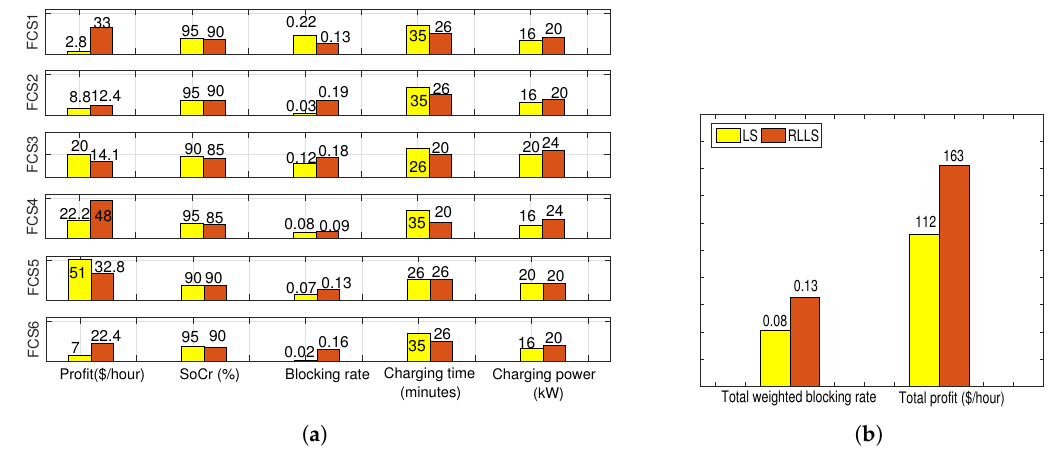
Figure 8. Performance comparison between LimitSoCr (LS) and RelocateLocationLimitSoCr (RLLS). ( a ) performance in six FCSs; ( b ) profit and total weighted blocking rate